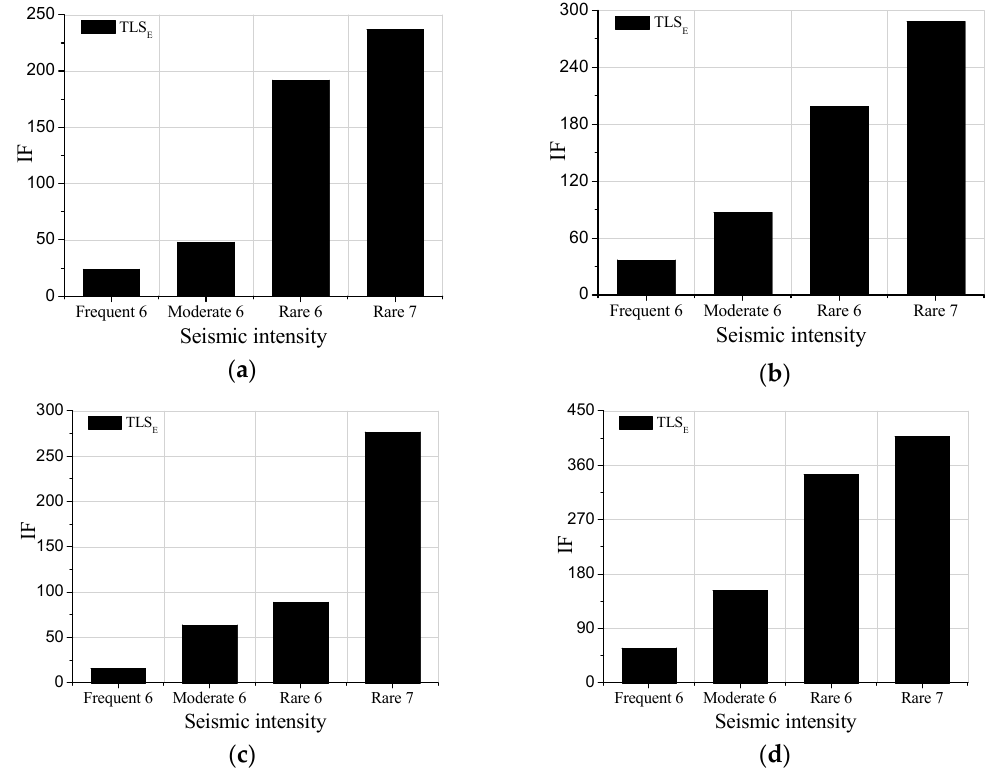
Figure 10. IFs of some floors after different earthquake intensities: ( a ) 8th floor; ( b ) 14th floor; ( c ) 41st floor; ( d )Top floor.